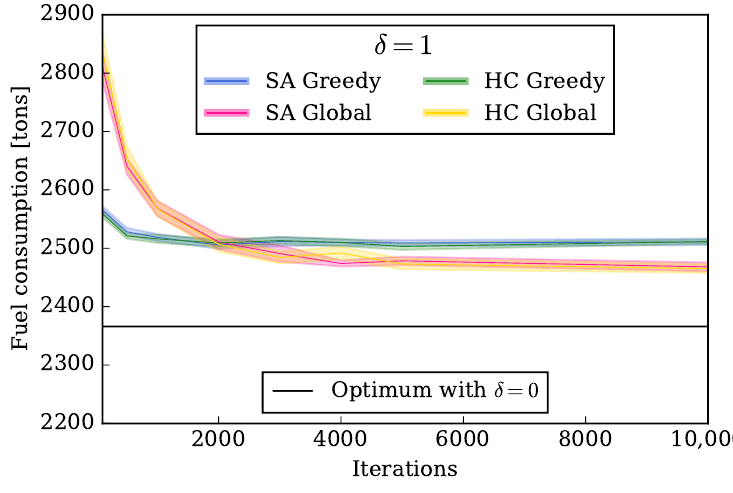
Figure 7. Total fuel consumption for the different techniques and δ =